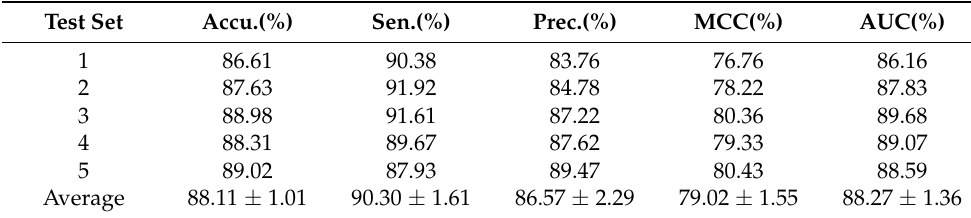
Table 2. 5FCV prediction results obtained by RoFDT on the Ion Channel dataset.